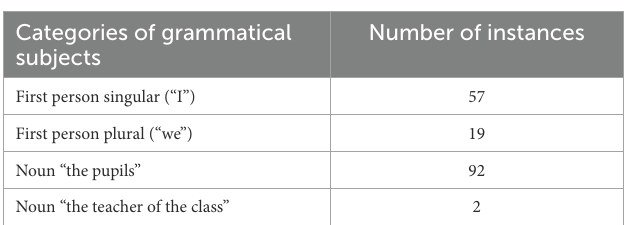
TABLE 2 “Animate”